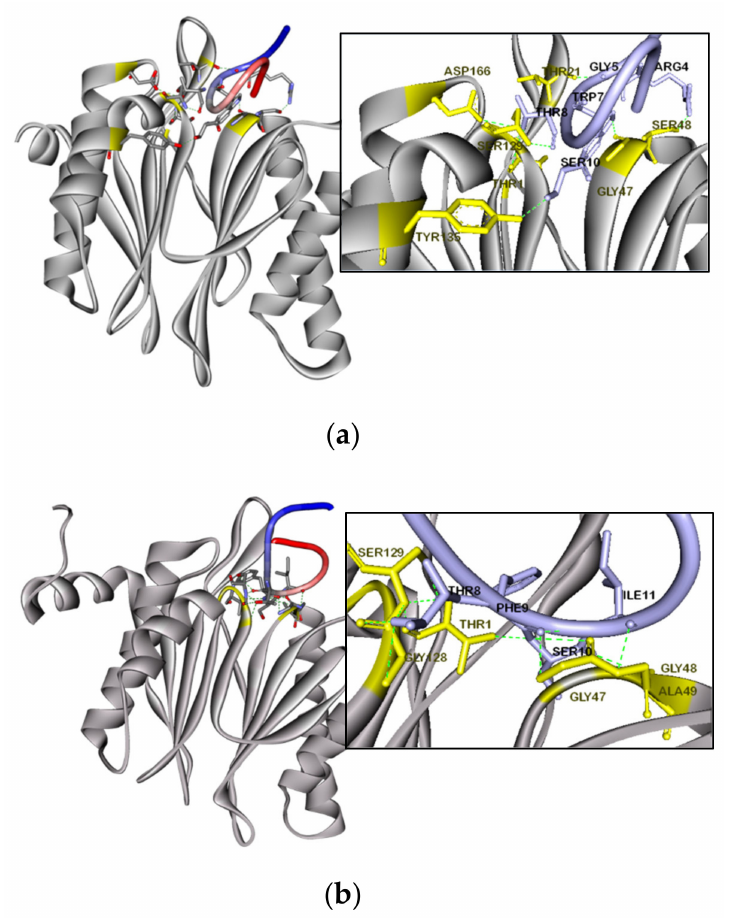
Figure 8. Simulated interaction of the protease-inhibitor docking for F-SL with β 1 ( a ) and β 5 ( b ) subunits of yeast 20S proteasome. The residues involved in the interaction on the corresponding subunits of F-SL (N-terminus is blue and C-terminus is red) were shown in stick representation. Possible active binding sites in subunits were highlighted in yellow and the hydrogen bonds were represented by green dotted